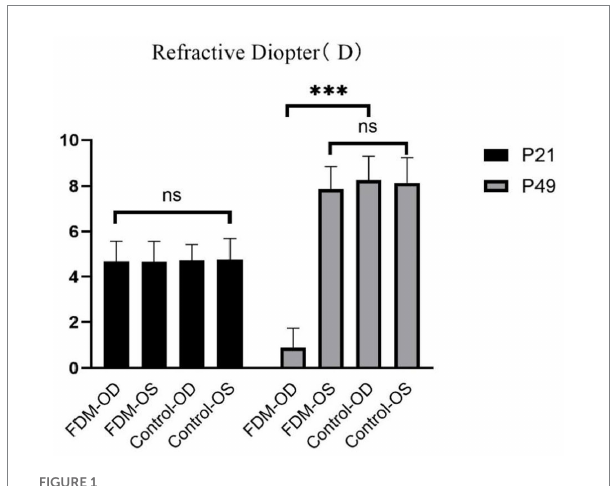
FIGURE 1 Refractions between the FDM and control groups. FDM: form-deprivation myopia; OD: oculus dexter; OS: oculus sinister.